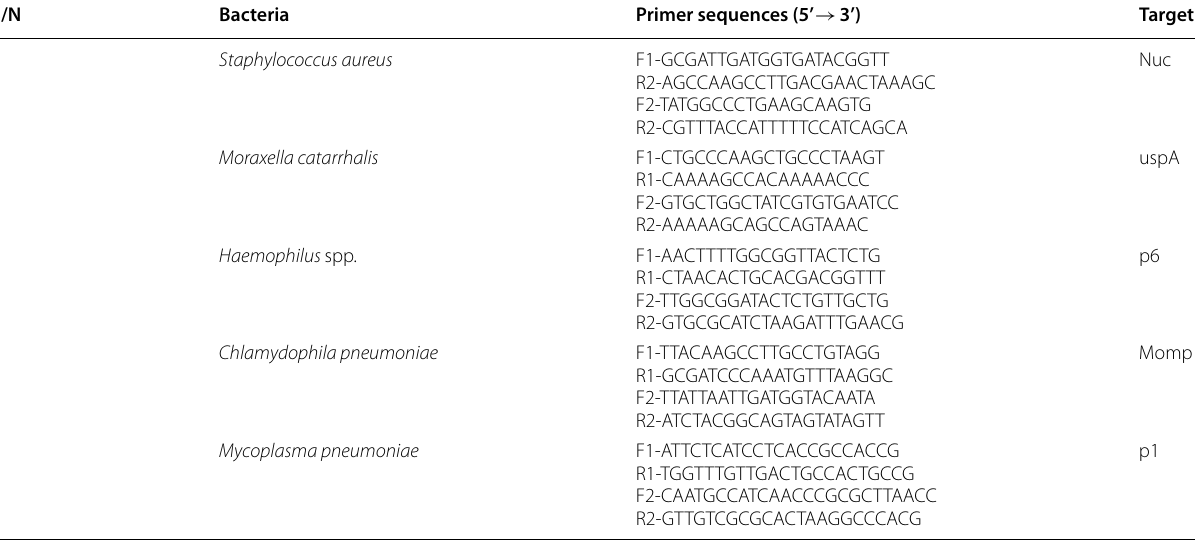
All primers adapted from Curran et al. (2007)